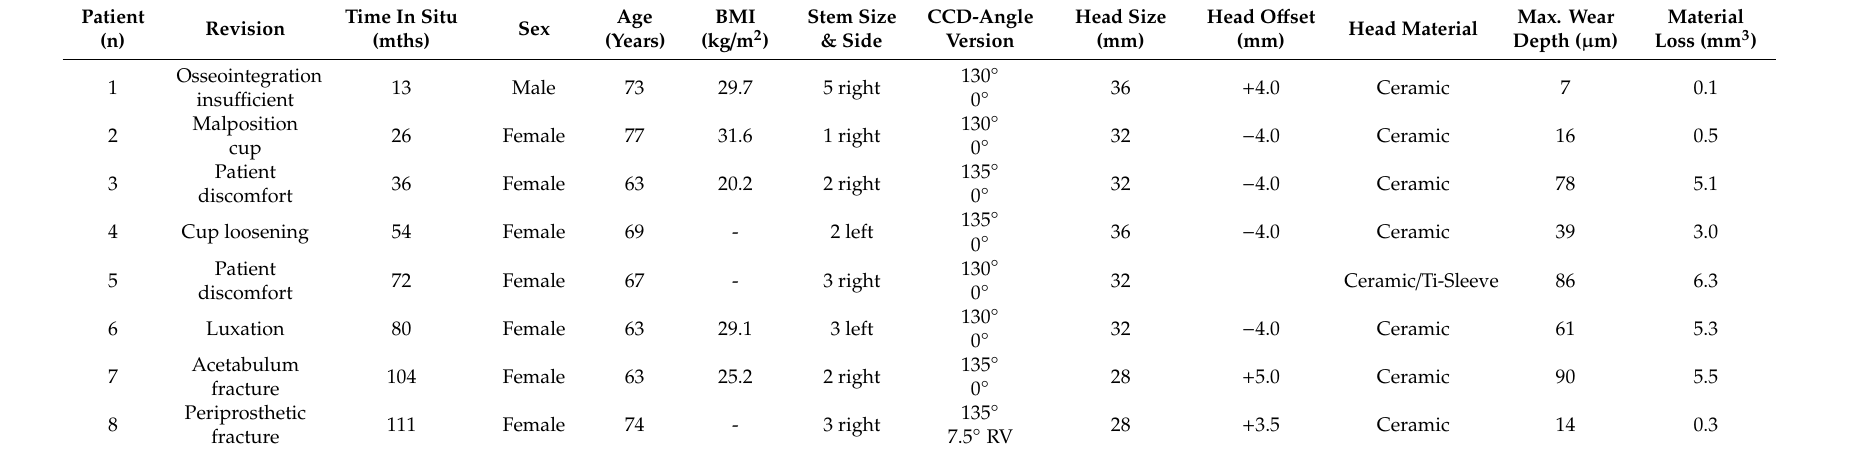
Table 3. Overview of eight asymptomatic clinical cases with retrieved CoCr dual taper neck